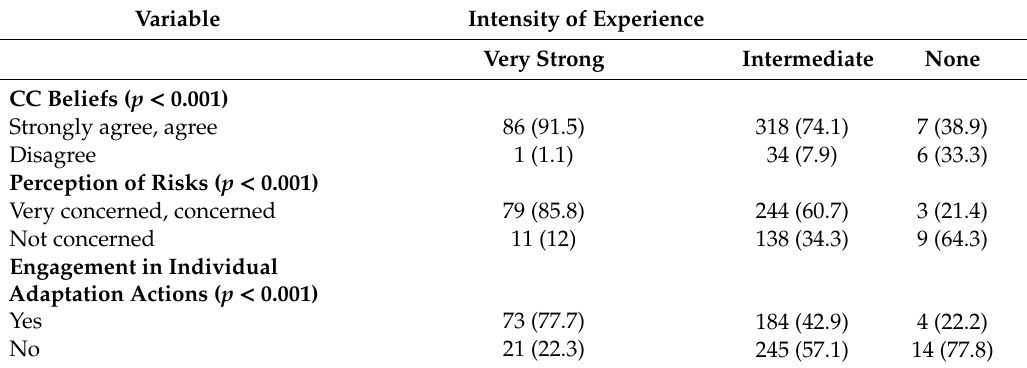
Table 4. Previous personal experience with extreme events and attitudes towards climate change (beliefs, perception of future risks, engagement in adaptation actions) among the general population in the Czech Republic, N